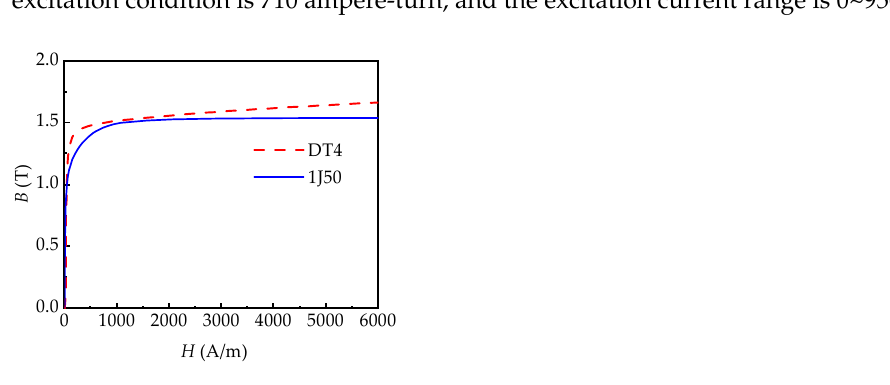
Figure 5. Static magnetic field model and meshing of valve.